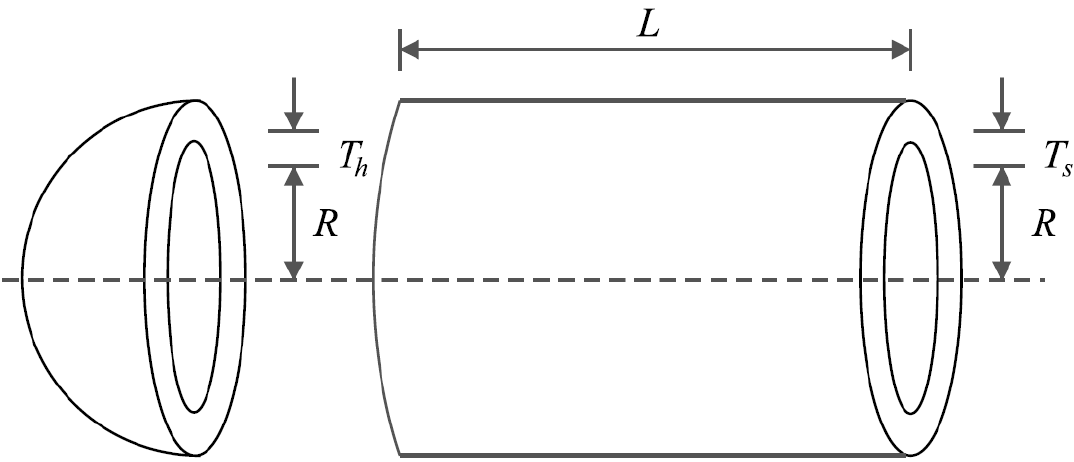
Figure 5. Schematic of pressure vessel design.